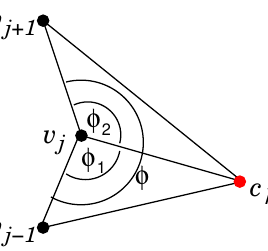
Figure 14. Construction of the initial polygonal line L 0 c 1 = ( 52.8,55 ) .